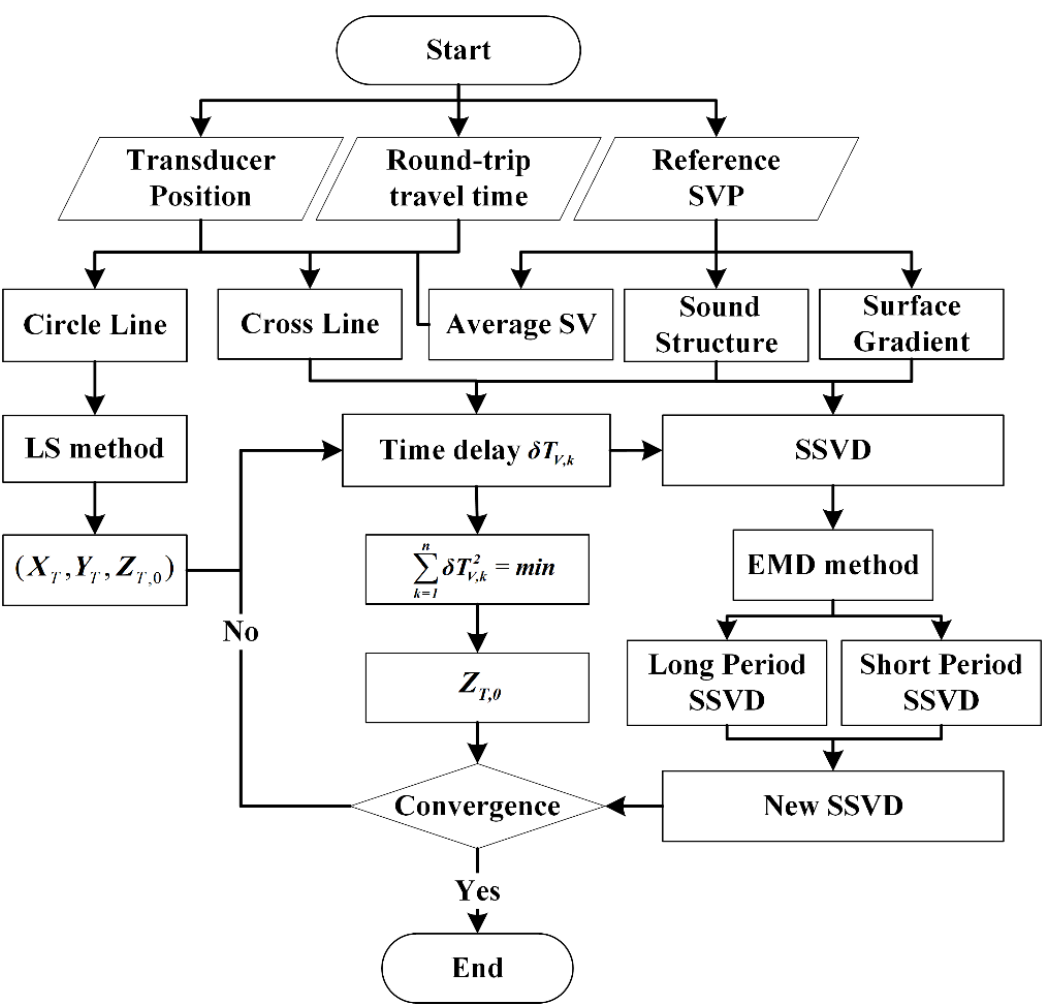
Figure 5. Algorithm of parameter estimation used to obtain the absolute vertical position and sound velocity variation.